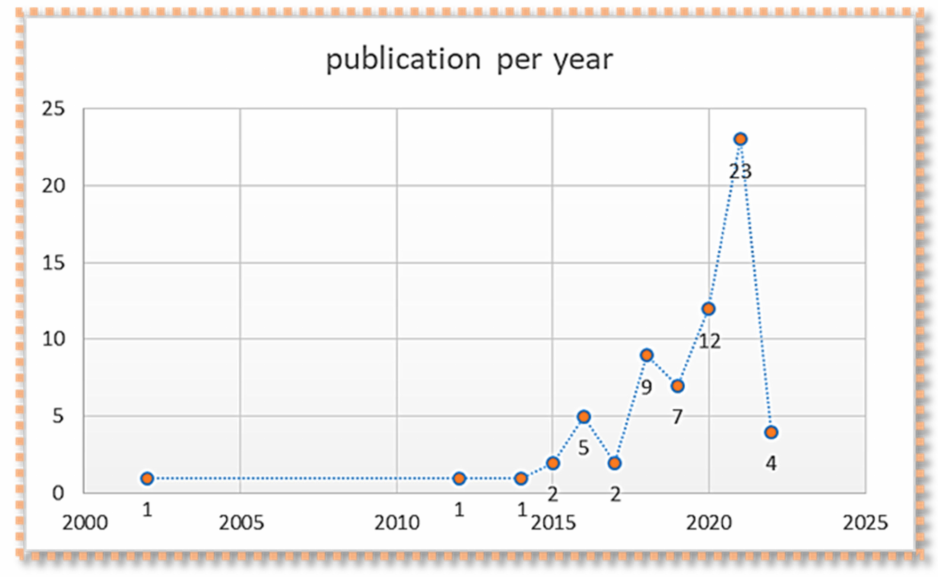
Figure 3. Annual scientific